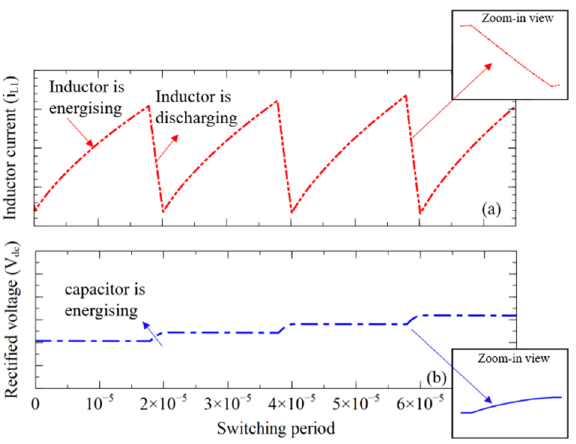
Figure 14. Inductor current and rectified voltage of the proposed converter.